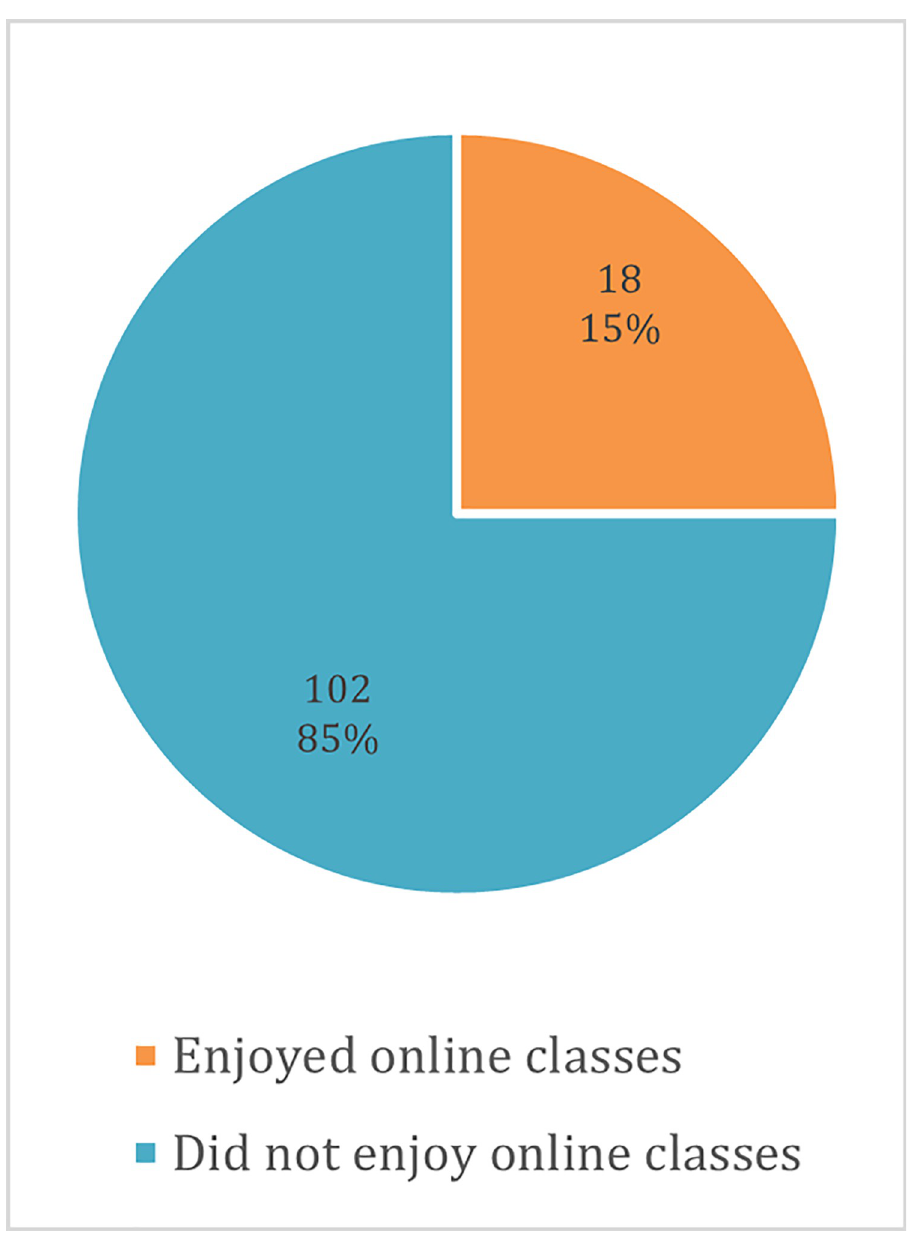
Fig 6. Students’ experiences of attending online